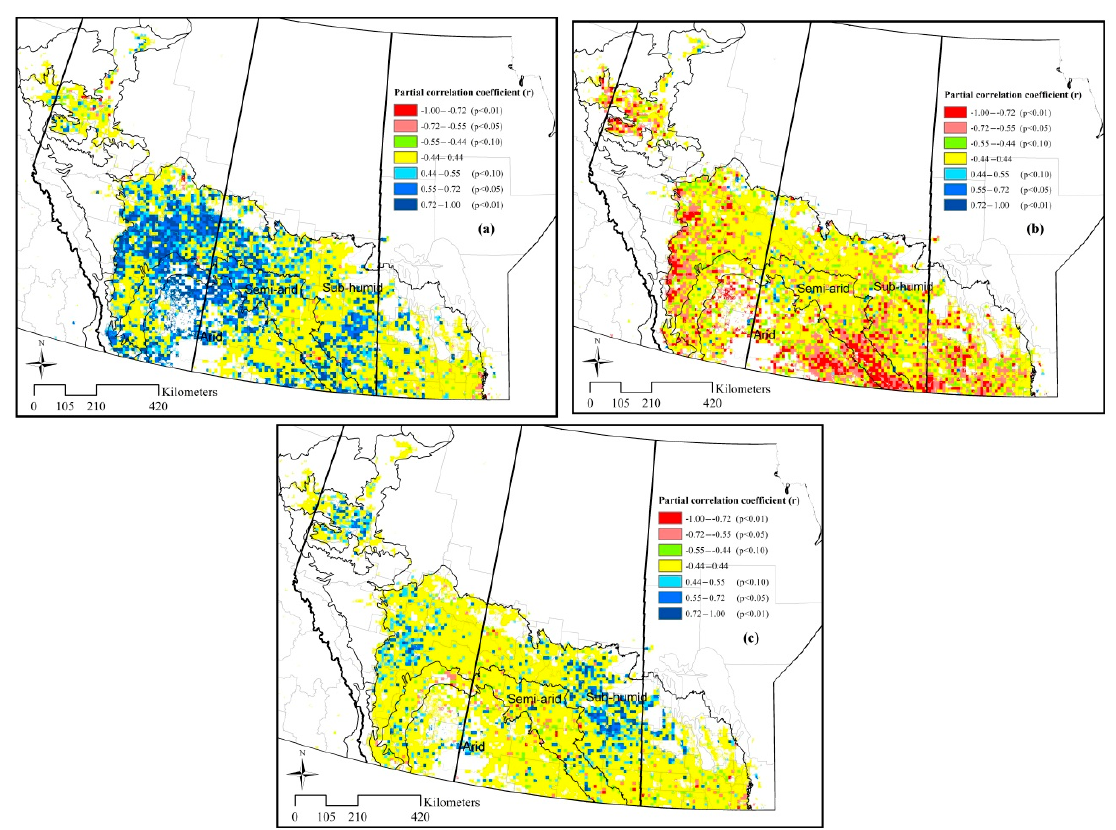
Figure 9. Spatial patterns of the partial correlation coefficient ( r ) between CFAPAR and climatic variables during the crop growing season; cumulative rainfall ( a ); growing season mean ( b ) temperature; and cumulative radiation ( c ), respectively.